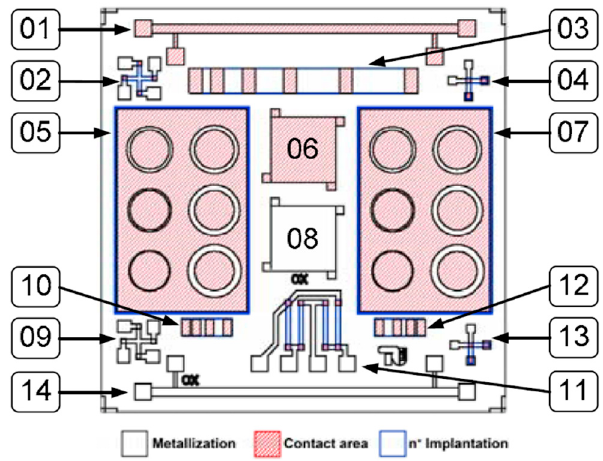
Figure 1. Test chip layout for electrical tests of the contact resistivity in the SiC–WSi–WSiN–Pt metallization system. The upper bone structure (structure 1) and the van-der-Pauw structures (structure 6) are used to characterize the metallization in contact with the substrate. Bone structures (structures 8 and 14) are used to measure the metallization sheet resistance. The Greek cross structure (structure 2) can be used to determine the semiconductor sheet resistance. The Greek cross structure (structure 9) can be used to determine the sheet resistance of the metallization stack. The structure 11 consists of 4 resistors is commonly used in a sensor device. The linear TLM structures (3, 10 and 12) and circular TLM (5 and 10) and two cross-bridge Kelvin resistors (4 and 13) are used to measure the specific contact resistivity.